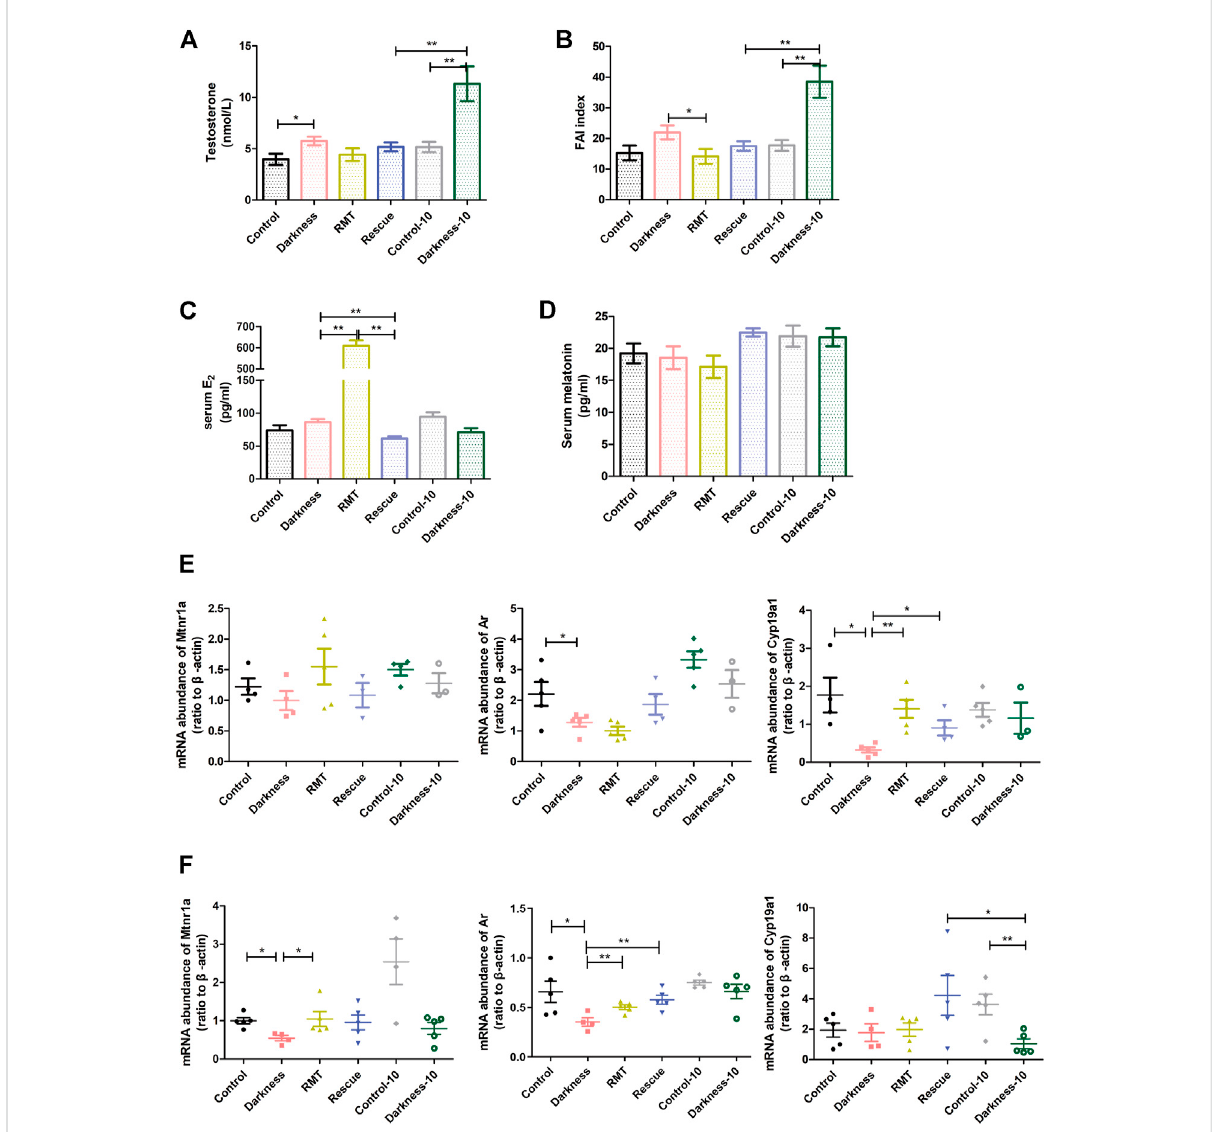
FIGURE 6 In fl uences of RMT and circadian rhythm restoration on the reproductive endocrine system and gene expression abundance. (A) Serum concentration of testosterone. (B) Free androgen index. (C) Serum estradiol content. (D) Serum concentration of melatonin. (E) Mtnr1a , Ar , and Cyp19a1 mRNA levels in ovarian GCs of each group of rats. (F) Mtnr1a , Ar , and Cyp19a1 mRNA levels in whole ovaries of each group of rats. N = 5/ group. Values are expressed as means ± SEM. Signi fi cant differences between the two groups are indicated by asterisks (* p < 0.05 and ** p <